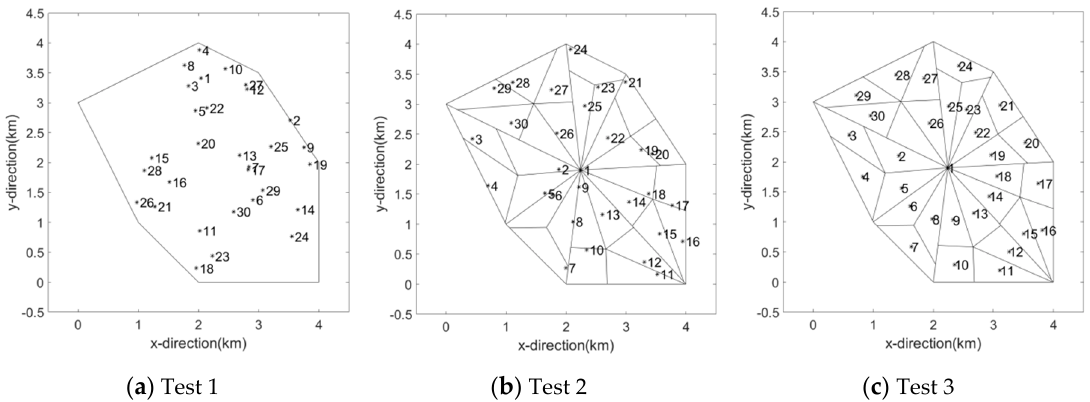
Figure 8. The initial position of UAVs obtained by three initialization methods: ( a ) is the result of random initialization; ( b , c ) are the results of the proposed initialization methods 1 and 2, respectively. The black “*” points represent the positions of the UAVs in the working area. The lines represent the dividing lines and boundaries.